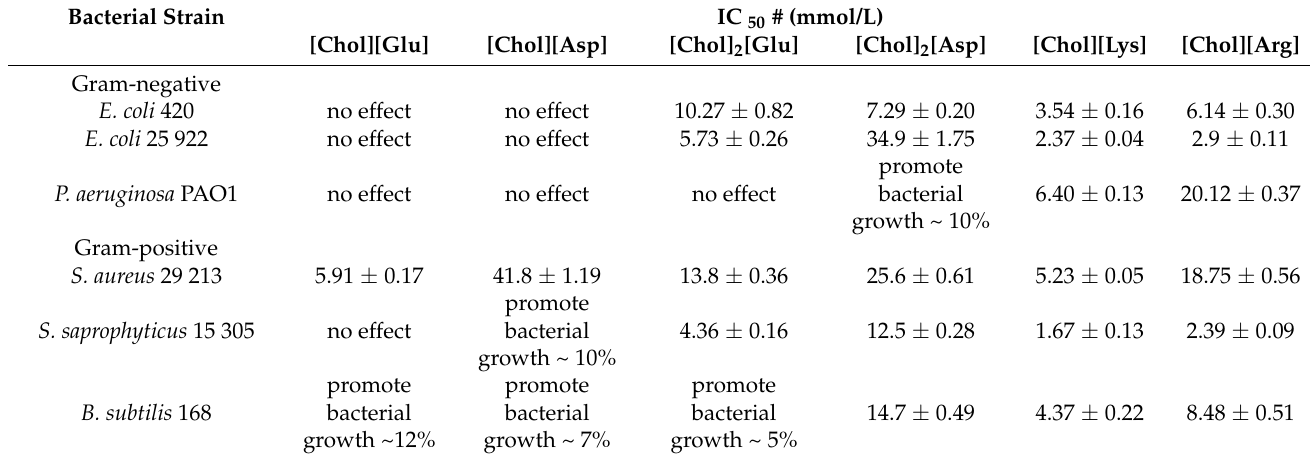
Table 1. Antibacterial activity of the [Chol] n [AA]